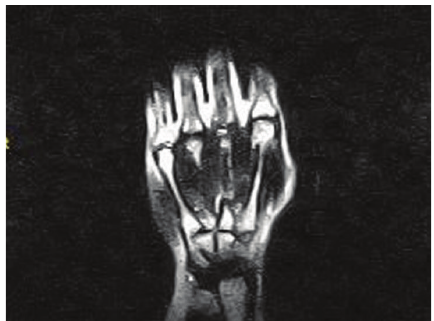
Figure 5: MR image of the volunteer with RFID tag attached to the wrist (imaging sequence: T 1 —Spin echo Coronal).